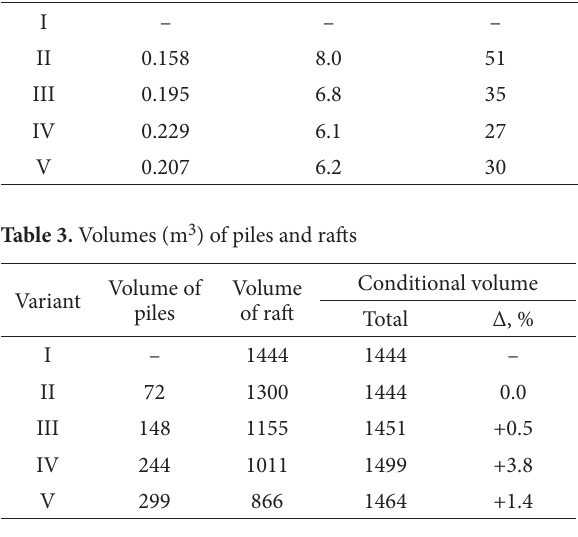
table 2. Relative parameters of pile distribution Relative area Relative spacing Variant α δ